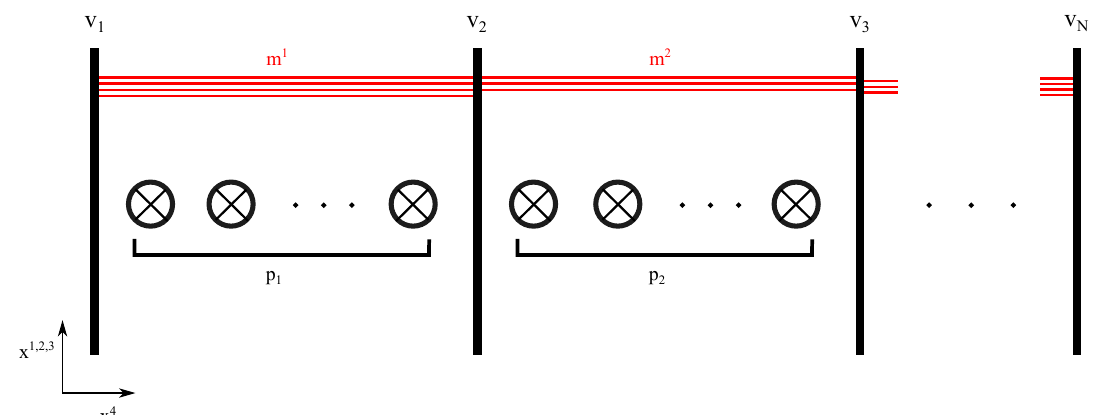
m I H I , and Higgs vev X 1 = I